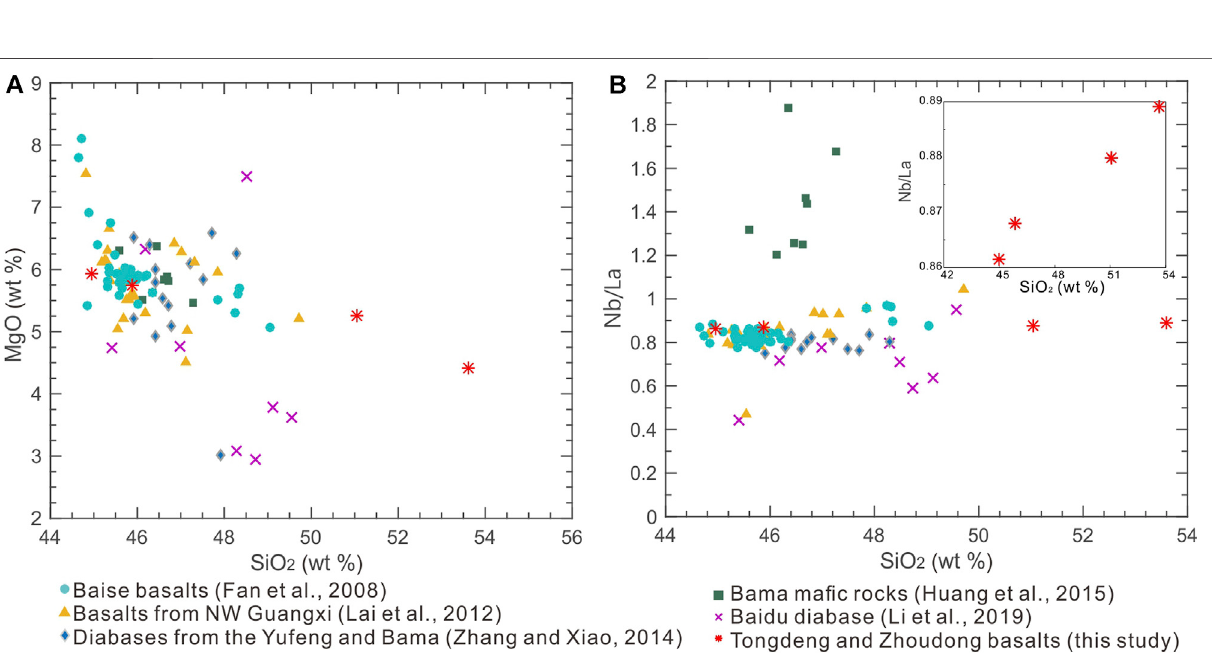
Frontiers in Earth Science |